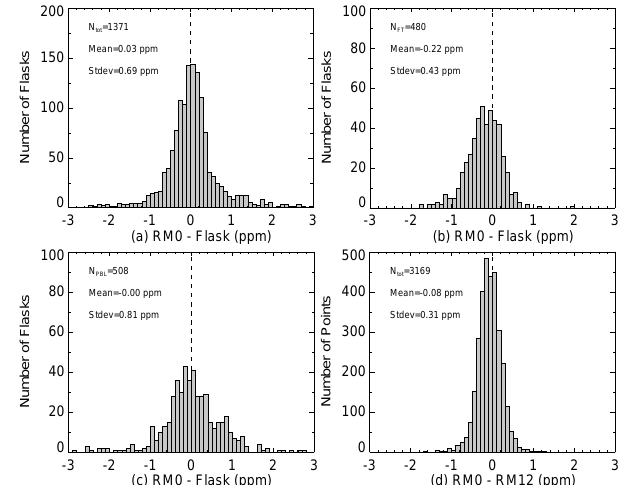
Fig. 6. Distribution of the difference calculated between: (a) all con- tinuous (RM0) and flask measurements, (b) RM0 and flask mea- surements collected above 3500m, i.e. in the FT, (c) RM0 and flask measurements collected below 1000m, i.e. within the PBL, during the November 2007 through March 2012 time period. The distri- bution of the difference calculated between two continuous CO 2 analyzers (RM0 and RM12) from observations collected between March 2011 and August 2011 is shown in panel (d) . Each point refers to the mean difference between a flask sample and the 1-min average of the continuous observations centered around the time that the flask was filling, one for each of the 12 steps during de-